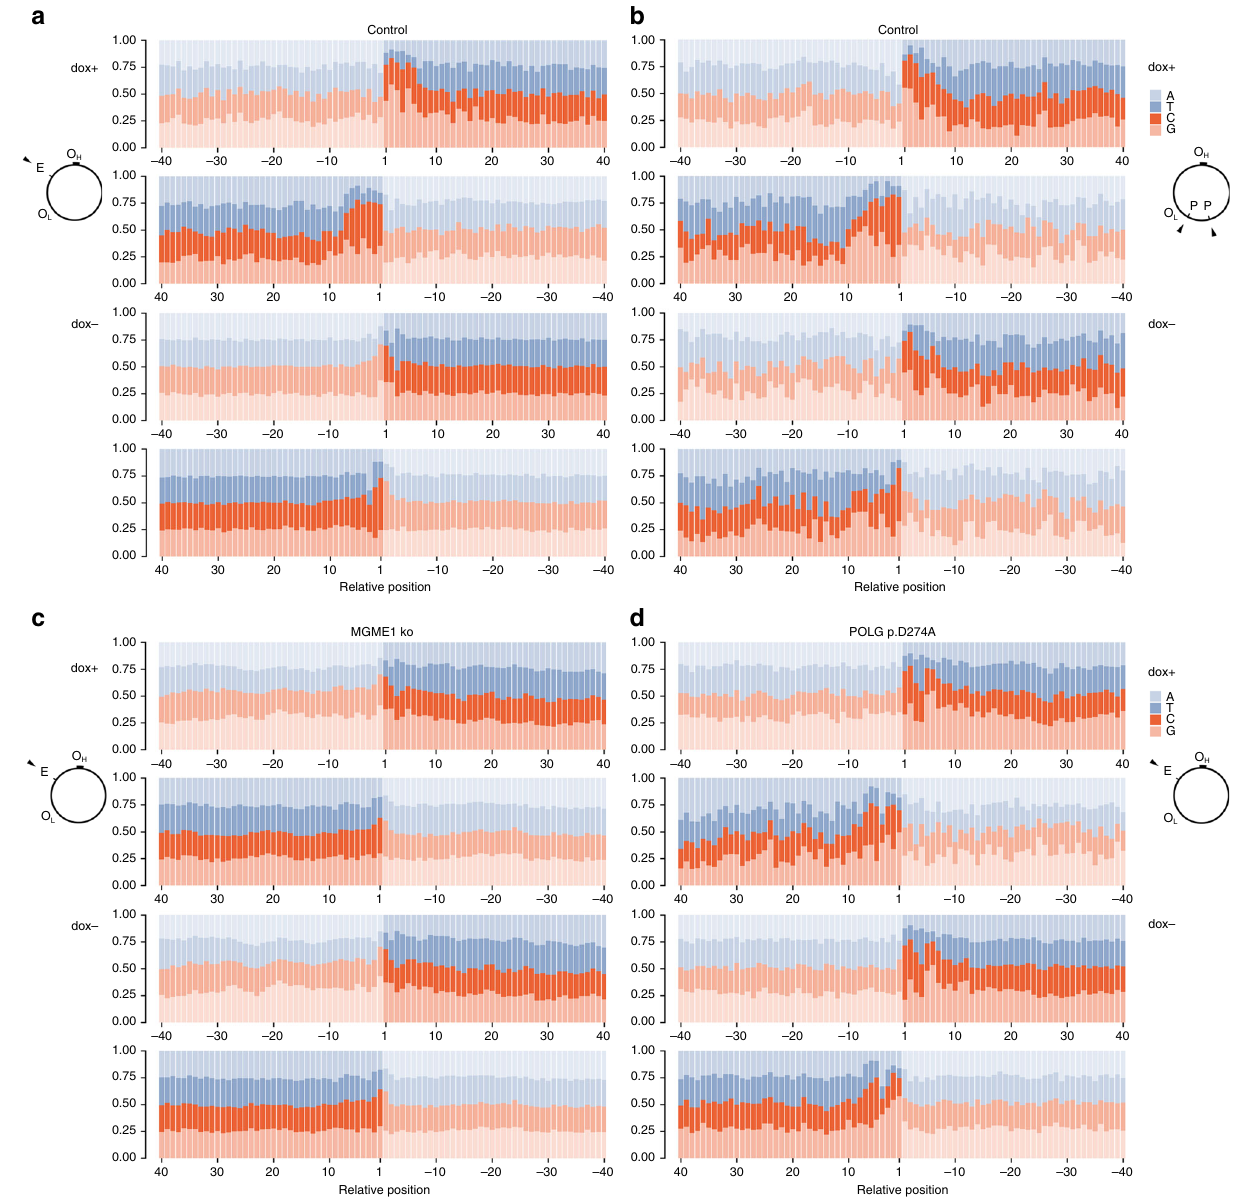
Fig. 4 GC stretches decelerate mtDNA degradation. Relative frequencies of nucleotides at the vicinity of detected blunt double-stranded mtDNA ends are shown. Nucleotides surrounding all ends detected by ultra-deep sequencing of linker-ligated mtDNA were counted and their relative frequencies were normalized to overall nucleotide frequencies in the mitochondrial genome. Ends at the immediate vicinity of the cutting site were excluded from the analysis (mitoEagI: positions 2552 – 2585; mitoPstI: positions 6810 – 7015 and 8920 – 9125). To avoid bias through the most prominent ends in mitoEagI cells, corresponding positions were also excluded (positions 5732 – 5742 and 3208 – 3215). ‘ dox + ’ , samples taken 6 h of inducing mitoEagI or mitoPstI expression. ‘ dox − ’ , no induction, only leaky mitoEagI or mitoPstI expression. Upper set of panels shows ends generated by degradation in the forward direction, lower set of panels in reverse direction (according to reference numbering). Faded balks represent removed nucleotides. a Note that the high frequency of guanine and cytosine residues at the fi rst 6 positions of linear mtDNA species upon induced cleavage in control mitoEagI cells. b Similar pattern can be observed in mitoPstI cells, although, cutting sites localize to different parts of the mitochondrial genome. c MGME1 knockout cells and d POLG p.D274A knockin cells do not show differences between induced and non-induced conditions. This is in line with the observation that newly generated ends do not undergo rapid degradation in the absence of MGME1 exonuclease or in the presence of exonuclease-de fi cient